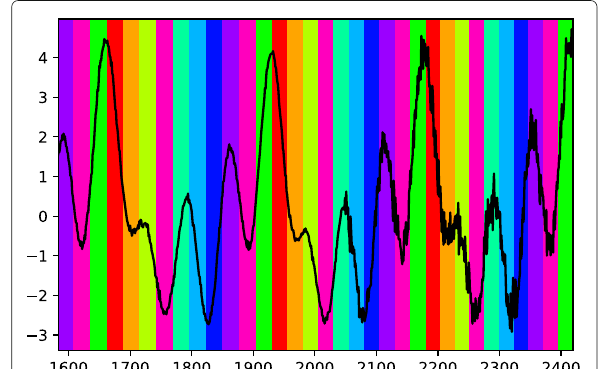
Fig. 11 Classifier with n 0 = 10, n n 0 = 8 applied to wave with slightly increased white noise ( σ = 4.77) starting at time stamp 2048